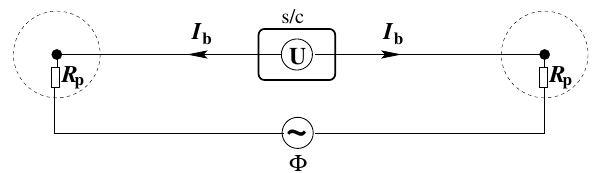
Fig. 1. The operational principle of a double probe instrument. Two boom-mounted probes (solid circles) are fed with identical bias cur- rents I b . If the resistances R p over the probe sheaths (dashed cir- cles) are equal, the voltage U measured on board the spacecraft will be equal to the potential difference Φ in the plasma between the probe locations. Unwanted electric field signals can arise either from a difference in R p between the probes, or from an asymmetric potential structure around the spacecraft and booms adding to the unperturbed Φ in the plasma. Currents close through the spacecraft sheath (not shown). For a more complete description, see Pedersen et al. (1998).